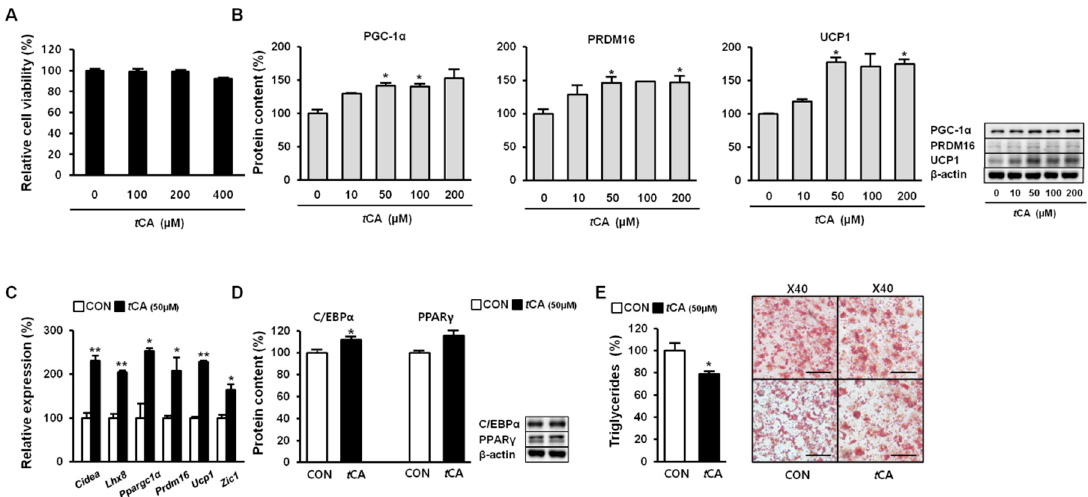
Figure 2. Trans -cinnamic acid ( t CA) activates brown adipocytes. Cytotoxicity of t CA upon induction in HIB1B cells ( A ). t CA elevates protein content of core brown fat markers ( B ) in a dose-dependent manner as well as expression of the genes encoding beige fat-specific activity ( C ) at 50 µ M in HIB1B adipocytes and regulates adipogenesis ( D ). Representative images of Oil Red O staining of HIB1B cells taken at 40 × magnification (scale bars = 50 µ m), where lipid content was quantified by extracting Oil Red O stain bound to cells with 100% isopropanol in brown adipocytes ( E ). Data are presented as the mean ± SD, and differences between groups were determined using the Statistical Package of Social Science (SPSS, version 17.0; SPSS Inc., Chicago, IL, USA) program, followed by Tukey’s post-hoc tests or Student’s t -test. Statistical significance between control and t CA-treated HIB1B cells are shown as * p < 0.05 or ** p <